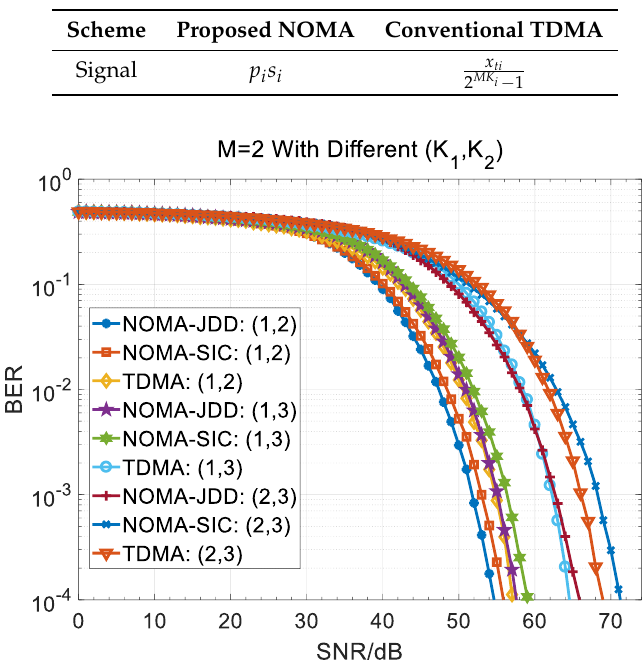
Figure 4. Two users’ average BER comparisons of our design and TDMA. SIC, successive interference